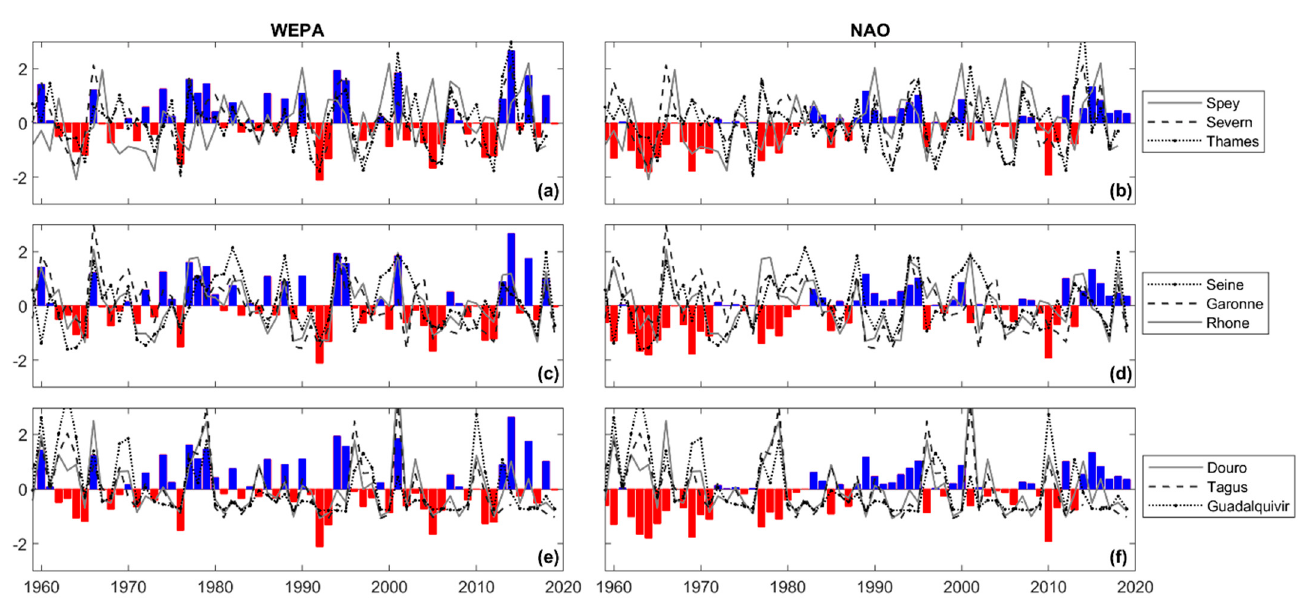
Figure 2. The 60 − year time series of winter-averaged WEPA ( a , c , e ) and NAO ( b , d , f ) indices with superimposed normalized winter discharge at nine rivers: ( a , b ) the Spey, Severn, and Thames in the UK; ( c , d ) the Seine, Garonne, and Rhône in France; ( e , f ) the Douro, Tagus, and Guadalquivir in the Iberian Peninsula.